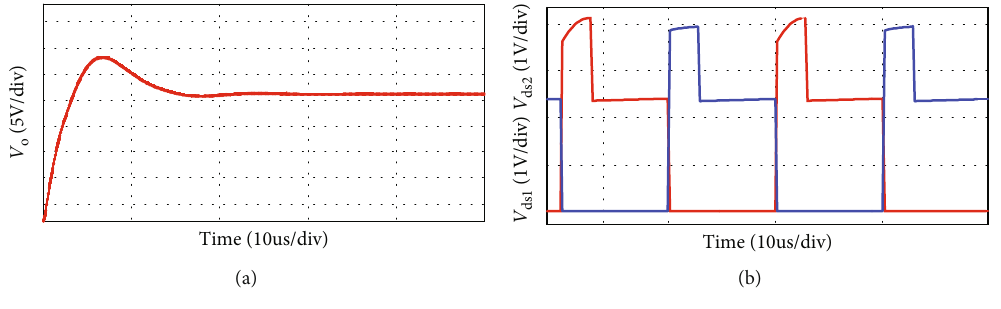
Figure 12: Voltage simulation waveform.